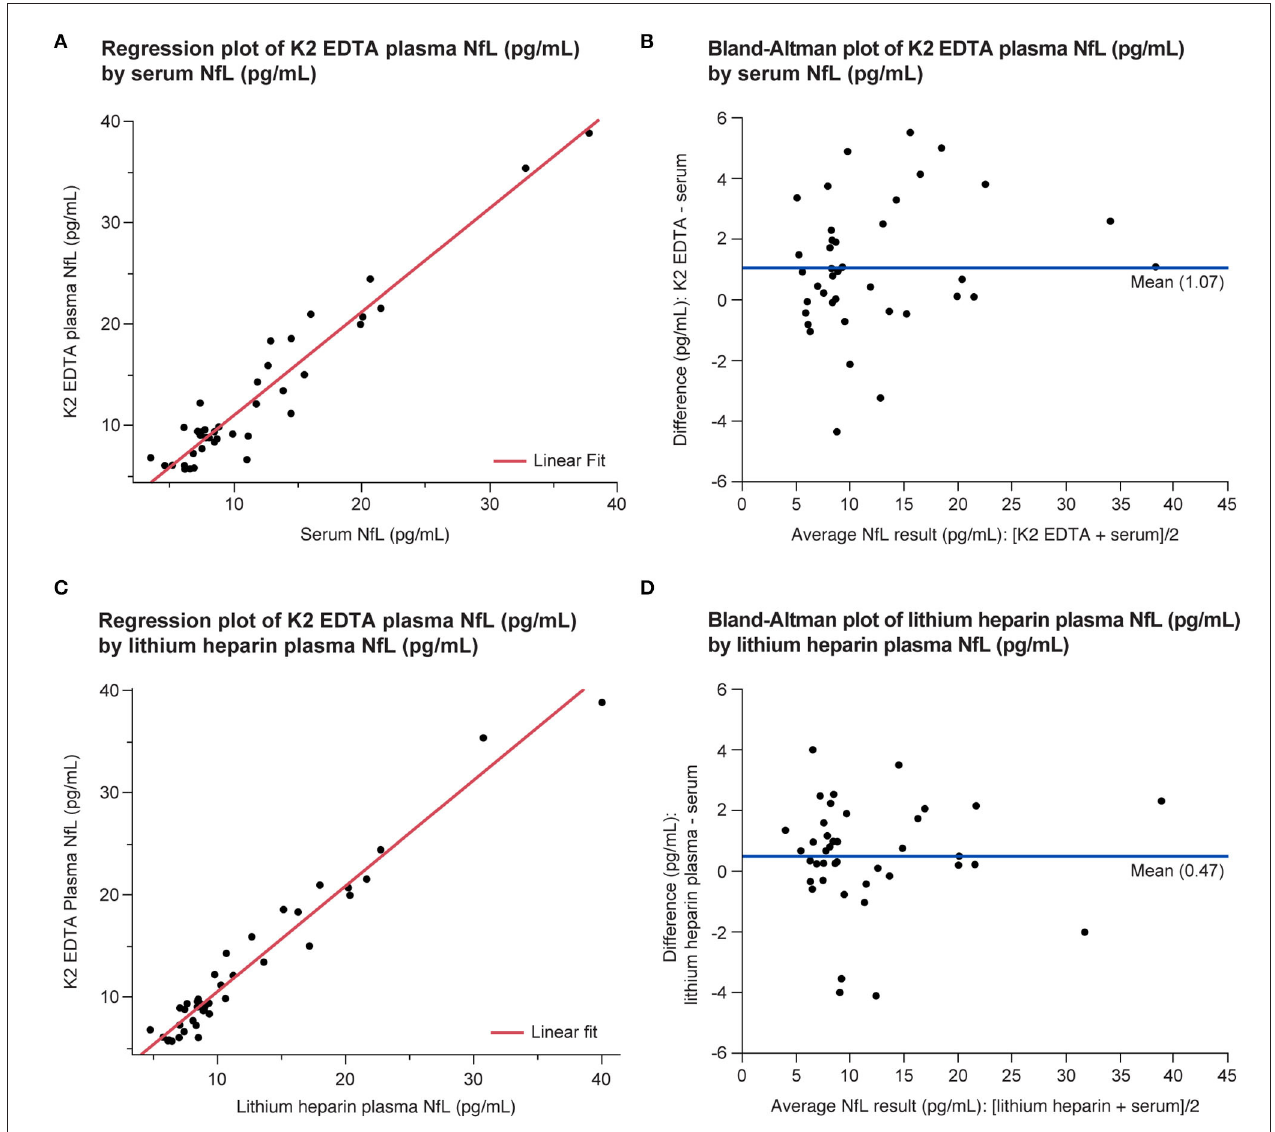
FIGURE 6 | Equivalence of serum and plasma NfL levels in the LDT implementation of the NfL assay shown as regression (A,C) and Bland-Altman plots (B,D) . LDT, laboratory-developed test; NfL, neurofilament light chain.